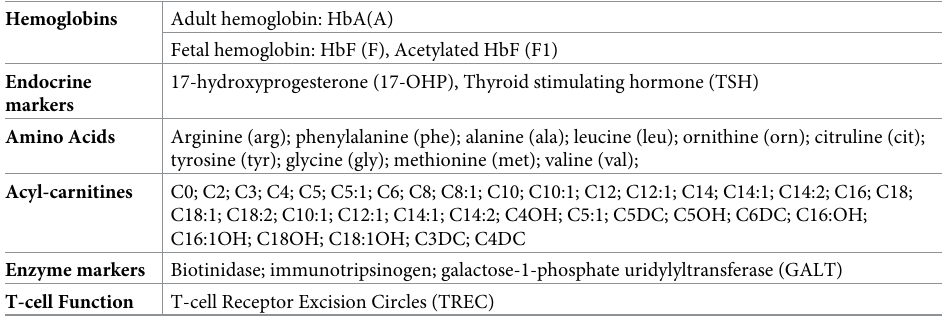
Table 1. Newborn screening analytes included in predictive